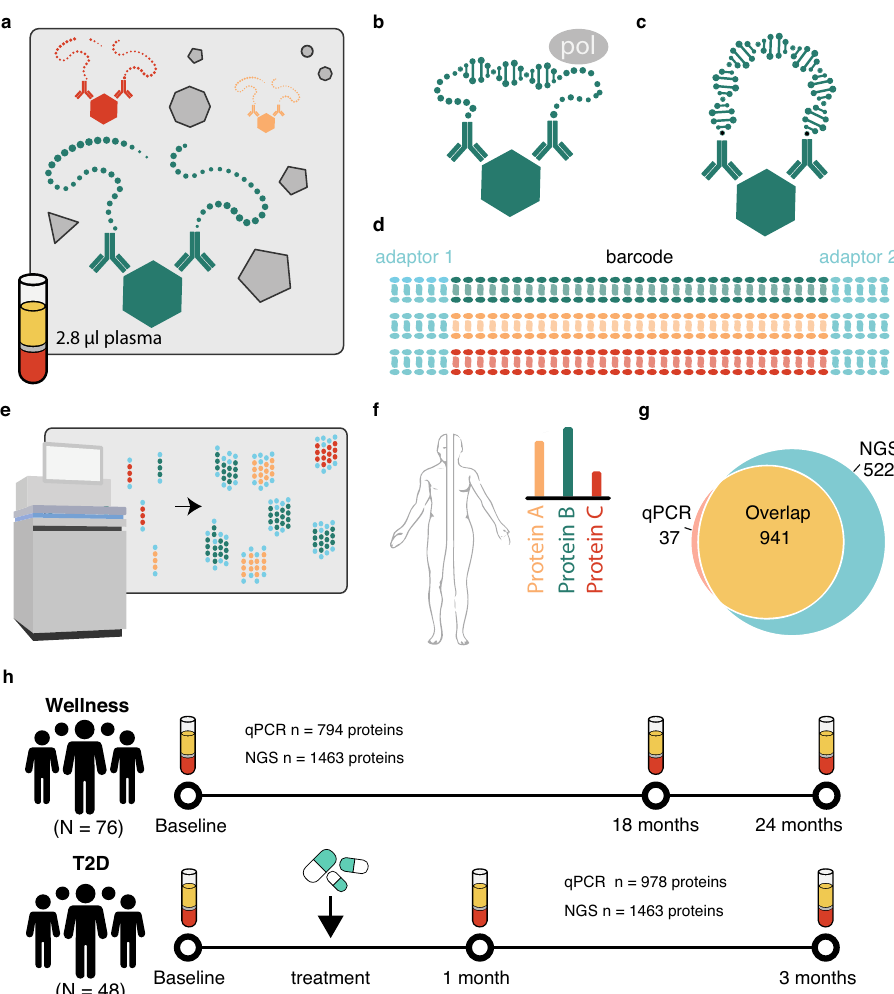
Fig. 1 Principle of the PEA-NGS method and description of cohorts. a DNA-conjugated antibodies bind to their target protein if present in the sample. b Antibodies with correct matched pairs can hybridize and are extended by DNA polymerase. c DNA-tags on correctly matched antibodies are extended and ampli fi ed through PCR ampli fi cation. d Unique barcode-regions identify each sample and protein and adaptors allow for NGS ampli fi cation and read-out. The color code indicates different barcodes. e NGS generates a digital signal, which translates to the number of DNA hybridization events that corresponds to the protein concentration in the original sample. f Relative protein concentration levels are obtained after normalization and quality control. g The number of protein targets in PEA-NGS as compared to the previous method based on qPCR assay. h Schematic description of the two analyzed